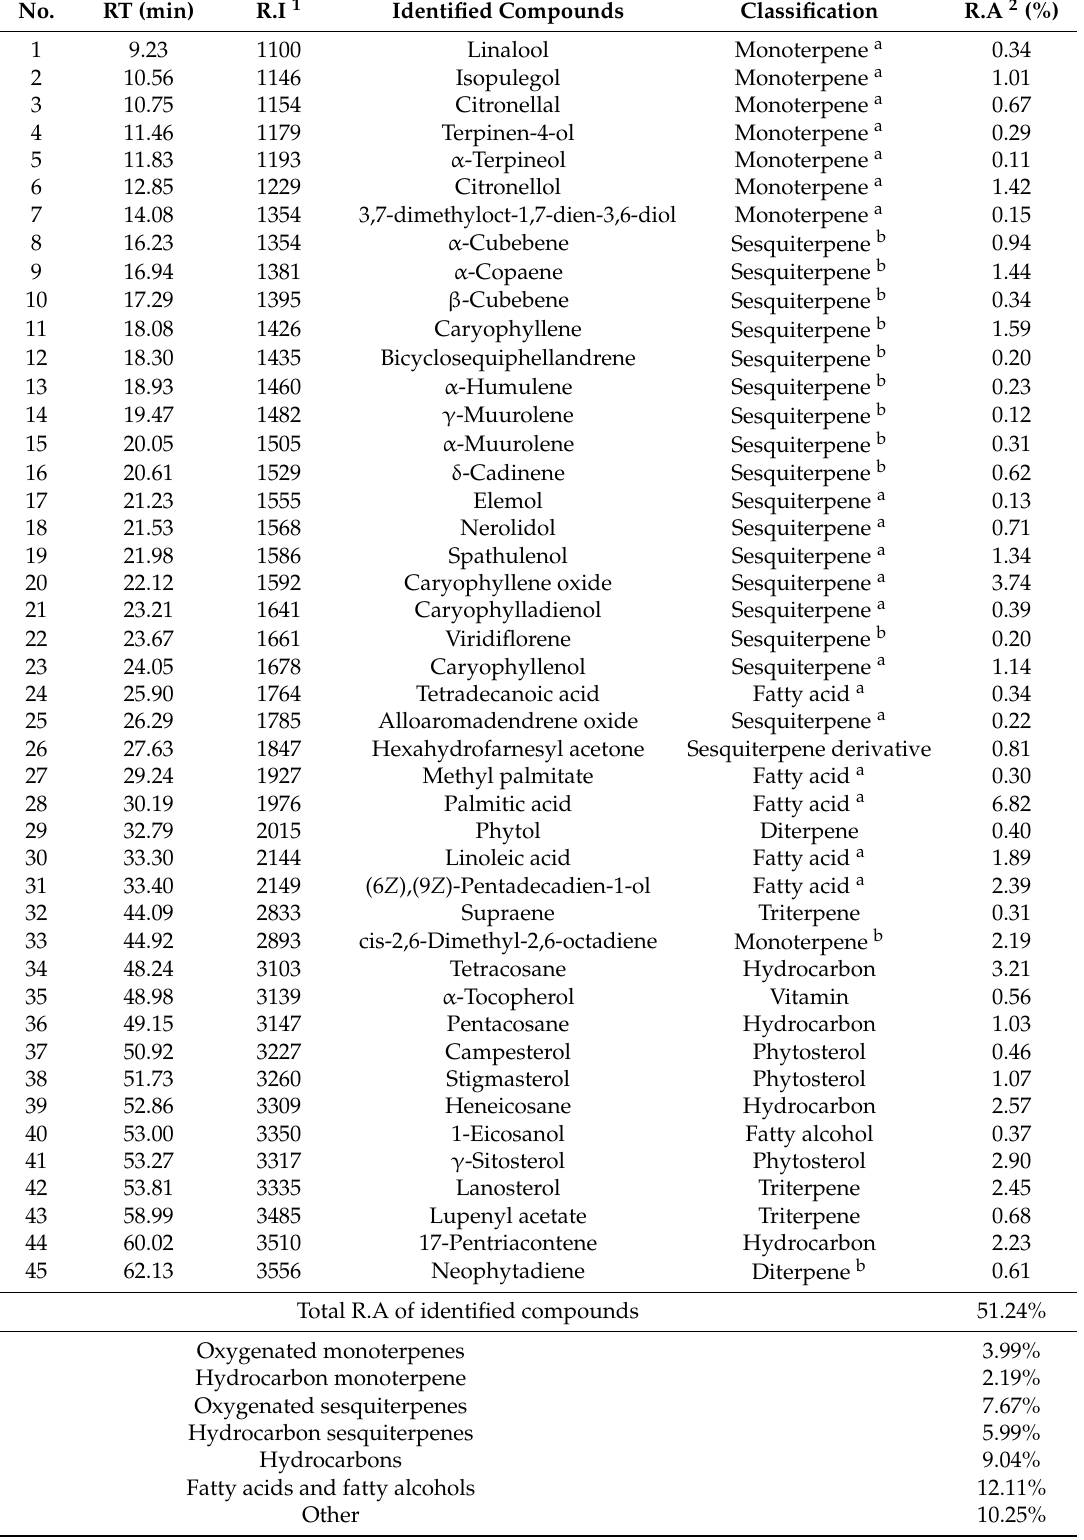
Table 1. The identified compounds from crude hexane by